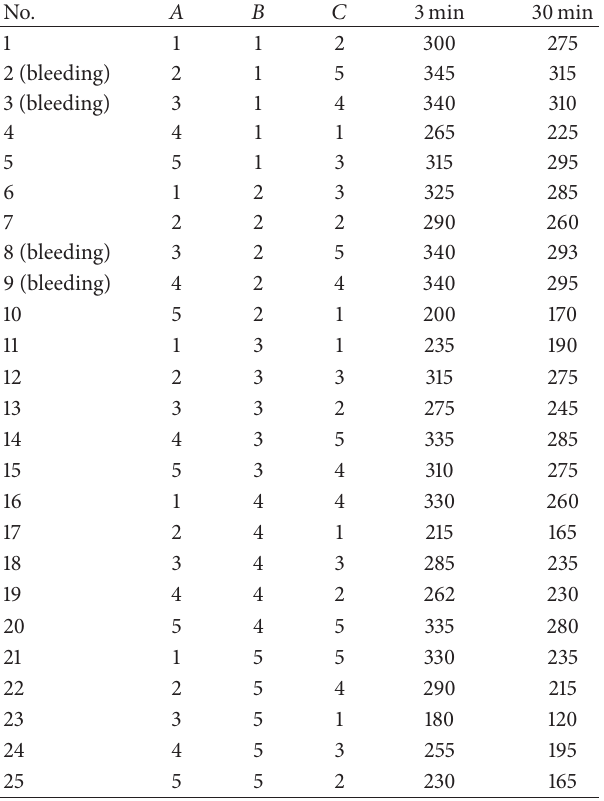
Table 4: Orthogonal experimental results.